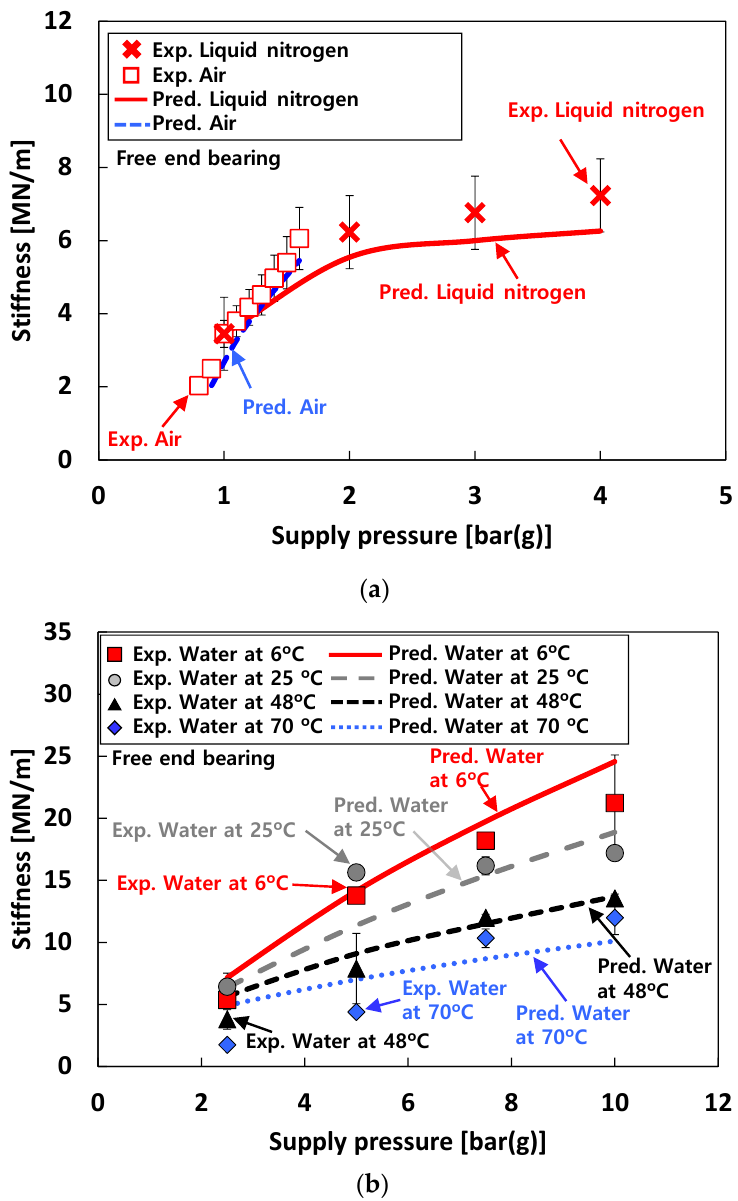
Figure 15. Predictions versus measurements. Test cases #1, #2, and #3: stiffnesses of free end bearing. ( a ) Test cases #1 and #3. ( b ) Test case #2.